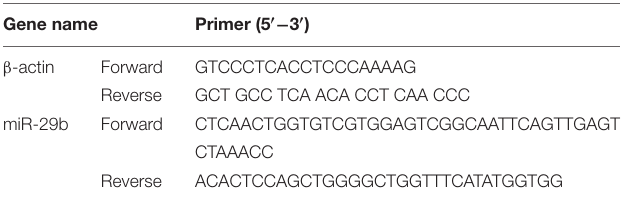
TABLE 1 | Primers sequences used for quantitative